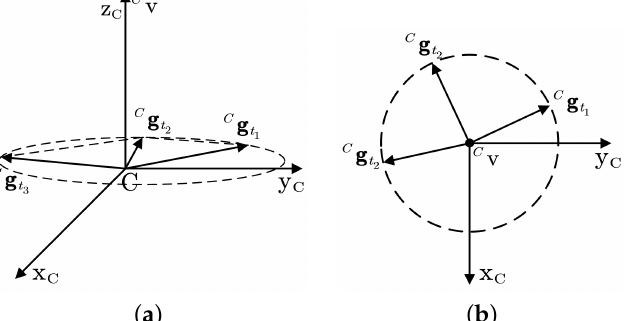
Figure 4. Trajectory of the measured acceleration in the frame C: ( a ) is the main view; and ( b ) is the top